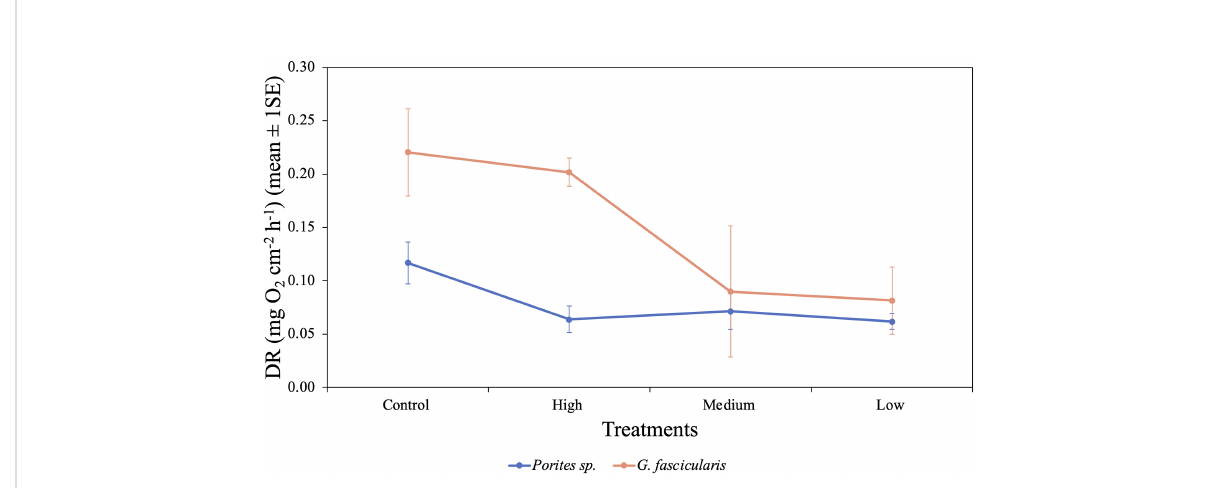
FIGURE 3 Mean (± 1SE) rates of dark respiration (mg O 2 cm − 2 h − 1 ) for Porites sp. and G. fascicularis under four different O 2 treatments.